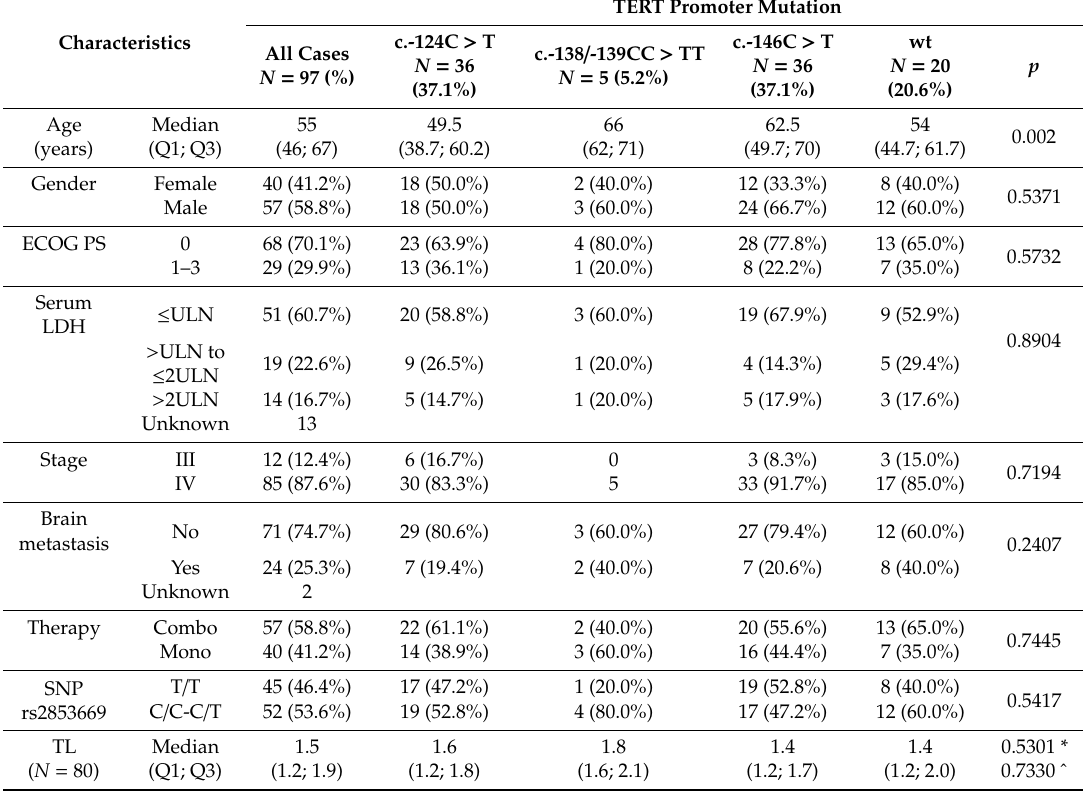
Table 1. Demographics, clinical and molecular variables, and their associations with telomerase reverse transcriptase (TERT) promoter mutations. ECOG PS—European Cooperative Oncology Group Performance Status; LDH—lactate dehydrogenase; ULN—upper limit of normal; SNP—single nucleotide polymorphism; TL—telomere length; wt—wild